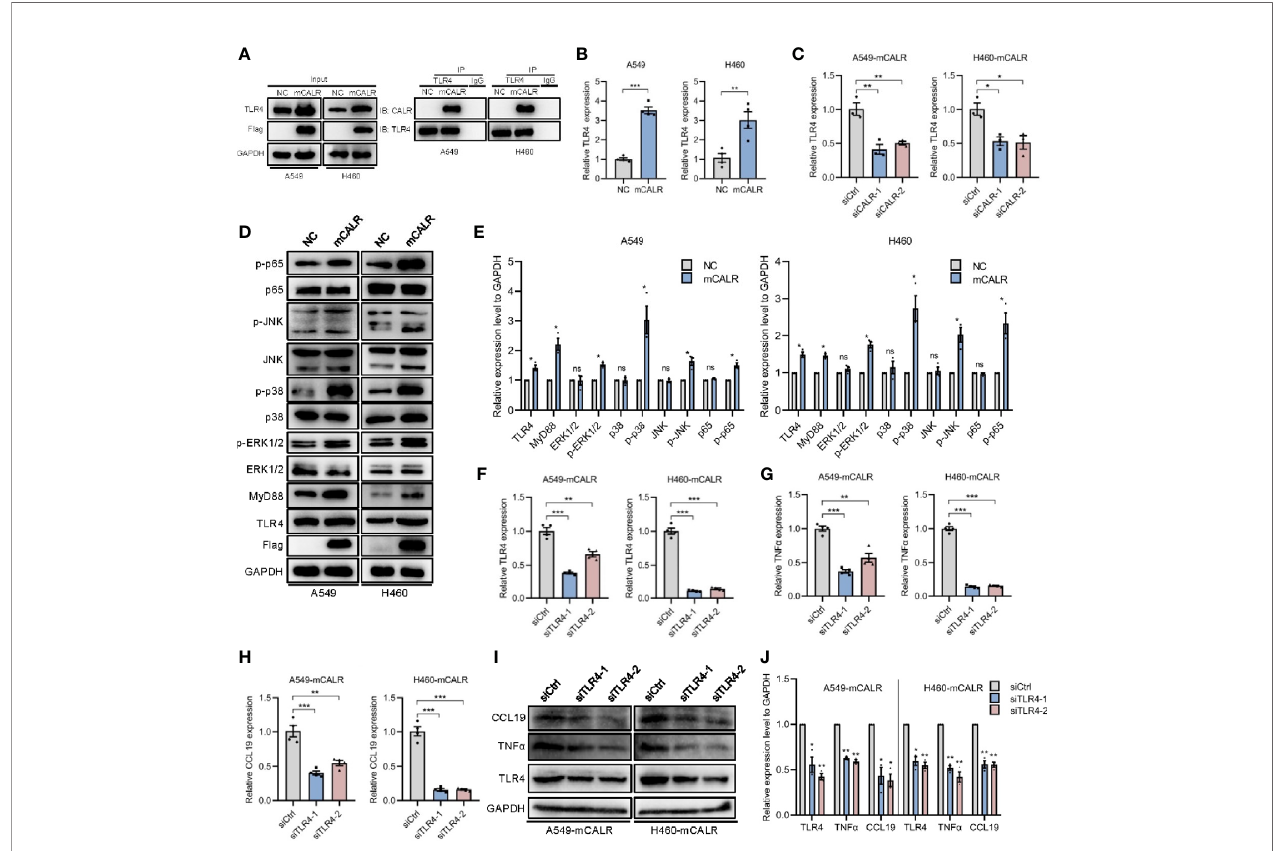
FIGURE 4 | mCALR enhances the secretion of TNF a and CCL19 via activating CALR-TLR4-MyD88 signaling. (A) The interaction between mCALR and TLR4 was assessed using co-IP assay in NC and mCALR cells, and the IgG antibody was used as a negative control. (B) The relative mRNA expression level of TLR4 was detected in NC and mCALR groups using real-time PCR; ** P < 0.01, *** P < 0.001. (C) The relative mRNA expression level of TLR4 was detected in siCALR and control groups using real-time PCR; * P < 0.05, ** P < 0.01. (D, E) The expression levels of mCALR, TLR4, MyD88, ERK1/2, p-ERK1/2, p38, p-p38, JNK, p-JNK, p65, and p-p65 were investigated in NC and mCALR groups using western blot, and the anti-Flag antibody was used to detect the mCALR protein; ns, P >0.05, * P < 0.05. (F – H) The relative mRNA expression levels of TLR4, TNF a , and CCL19 were detected in mCALR cells transfected with different siTLR4 using real-time PCR; ** P < 0.01, *** P < 0.001. (I, J) The expression levels of TLR4, TNF a , and CCL19 were investigated in mCALR cells transfected with different siTLR4 using western blot; * P < 0.05, ** P <